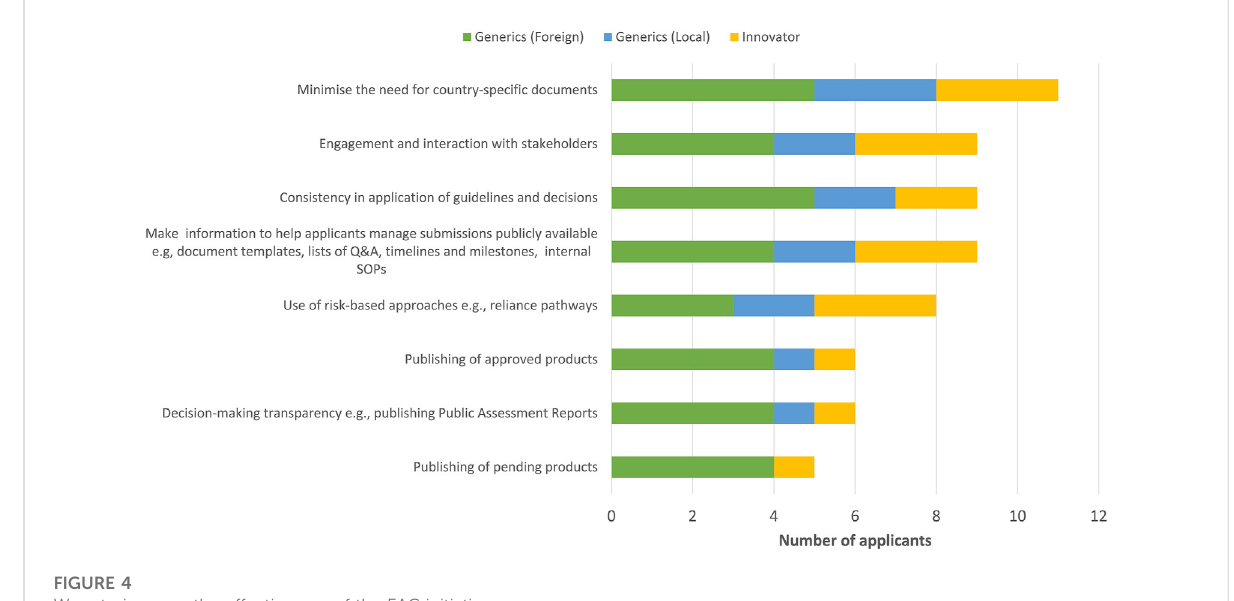
FIGURE 4 Ways to improve the effectiveness of the EAC initiative.